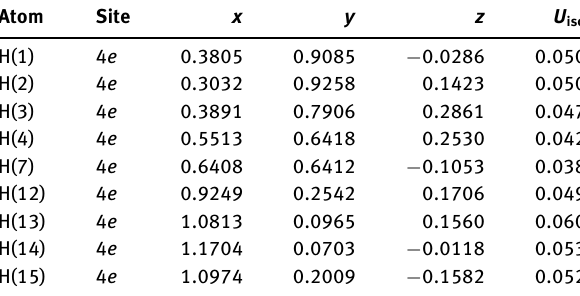
Table 2: Fractional atomic coordinates and isotropic or equivalent isotropic displacement parameters (Å 2